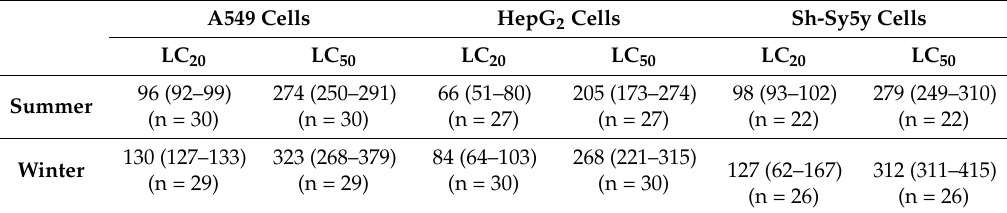
Table 3. LC 20 and LC 50 ( µ g/mL) of PM 2.5 in summer and